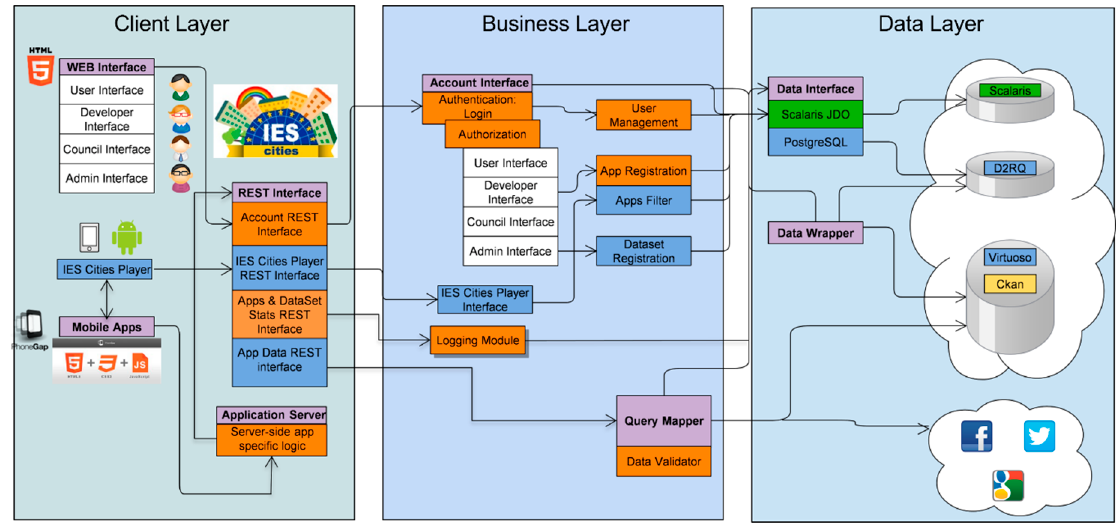
Figure 1. Diagram of the architecture of the IES Cities’ platform showing relations among different components.